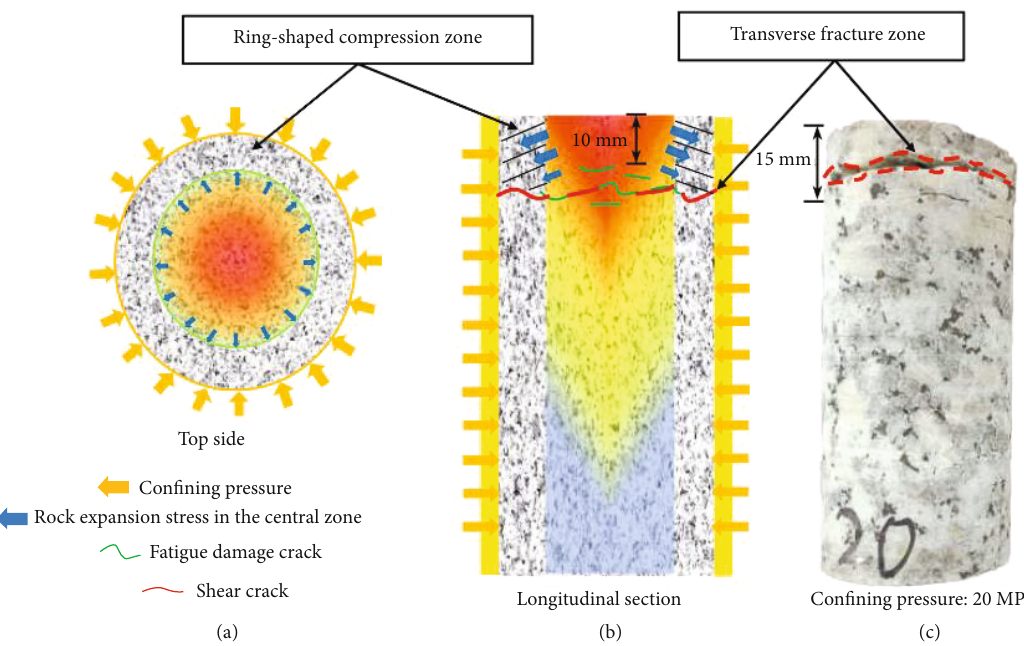
Figure 10: Rock stress distribution states and failure development under UHF impact subjected to con fi ning pressure: (a) stress distribution on granite loading surface; (b) stress distribution and damage development on granite longitudinal section; (c) fracture model of granite under UHF impact subject to the con fi ning pressure of 20 MPa.